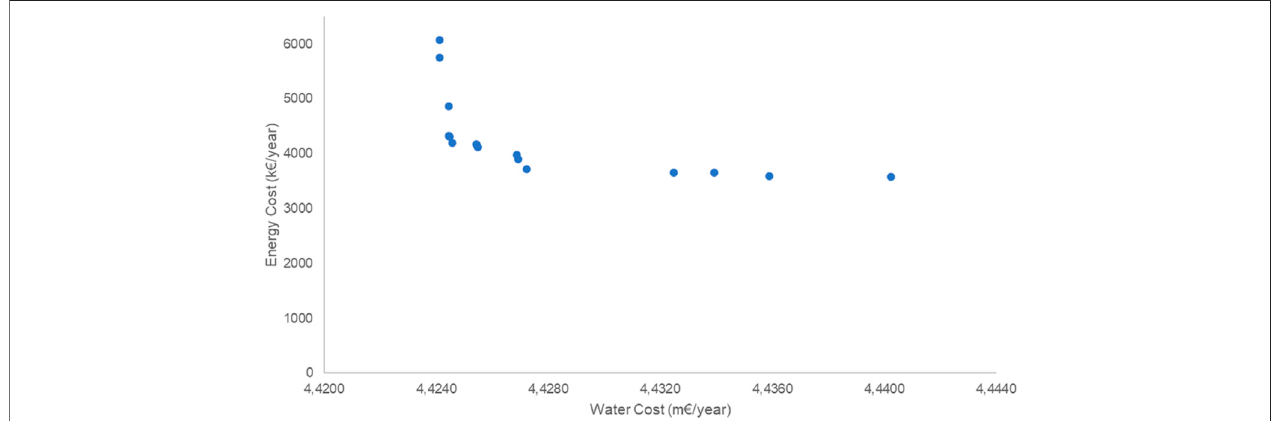
FIGURE 3 | Pareto front generated by the solving of the MOP model optimisation